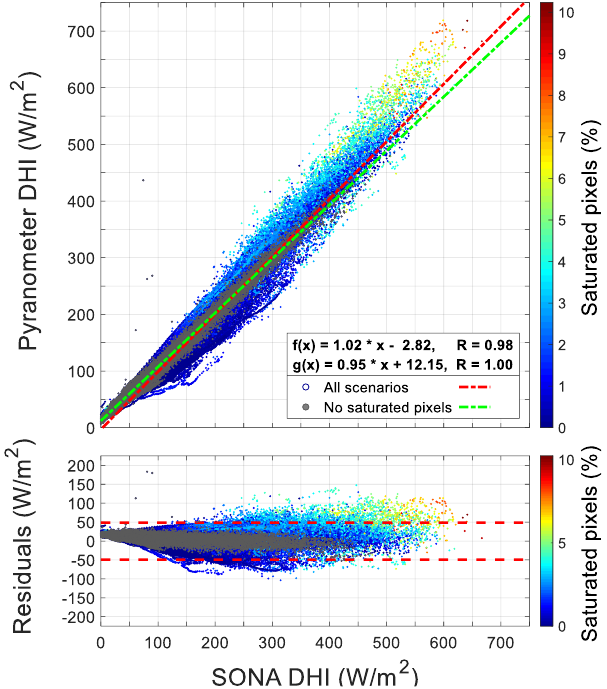
Figure 12. Comparison of the pyranometer DHI vs. SONA DHI from 28 March to 27 July 2021. SONA DHI were computed by applying the spectral response correction obtained in the comparison against the pyranometer, treating the saturated pixels as the maximum radiance. The color bar accounts for the percentage of saturated pixels in each image, while the grey color represents the images with no saturated pixels. f(x) is the fit function for all the images, represented by the red colored line, and g(x) is the fit line using only images without saturated pixels, represented by the green colored line. Two red dashed lines represent the 95% confidence interval of the residuals.